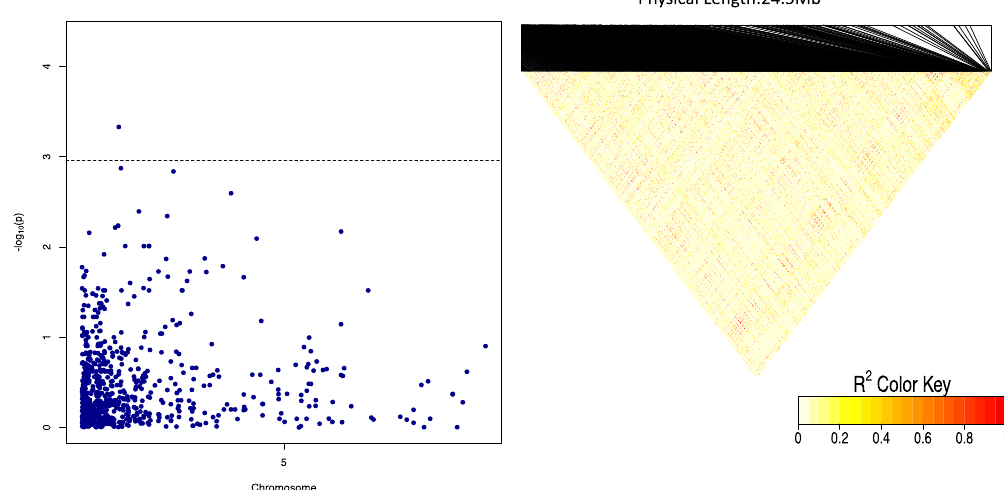
Figure 8. Linkage disequilibrium (LD) heatmap showing pairwise LD between the SNP markers covering the entire chromosome 5 carrying genes encoding for OxB. The red colour shows the markers with high LD followed by yellow then the white colour. The dashed lines on the Manhattan plot represent the significant threshold while the X-axis presents physical distances.